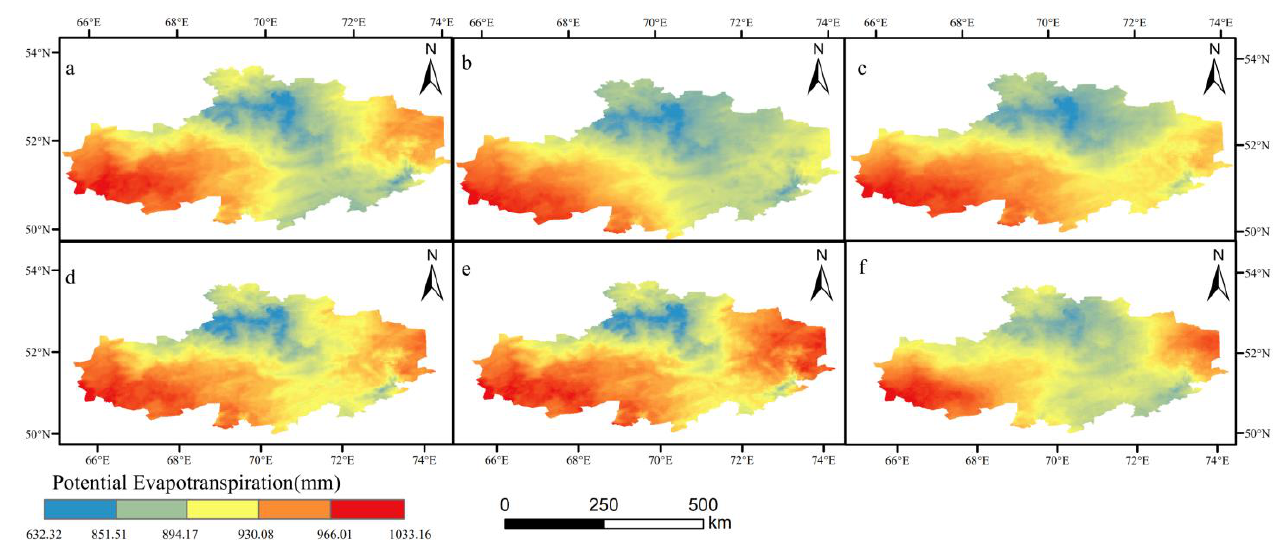
Figure 2. Spatial and temporal distribution of PET in Akmola State ( a – f ), representing the spatial and temporal distribution of PET in Akmola State in 1991, 1997, 2003, 2009, 2016, and 2021. As shown in Figure 3 and Table 2, in Akmola Oblast, only 6.39% of the regions pre- sented an increase in potential evapotranspiration from 1991 – 2021, located in Imeni Kostycheva in the western part of the oblast and Kokshetau and Valikhanovo in the north- ern part of the oblast, with the highest interannual variation rate of 6.39 mm/yr. The re- gions with a decrease in annual potential evapotranspiration in the study area accounted for a relatively small annual rate of change in PET in the study area. Overall, the PET in the study area showed a decreasing trend (Figure 3i), and the PET fluctuated more fre- quently in magnitude and trend over time. Table 2. Data sources and basic parameters.